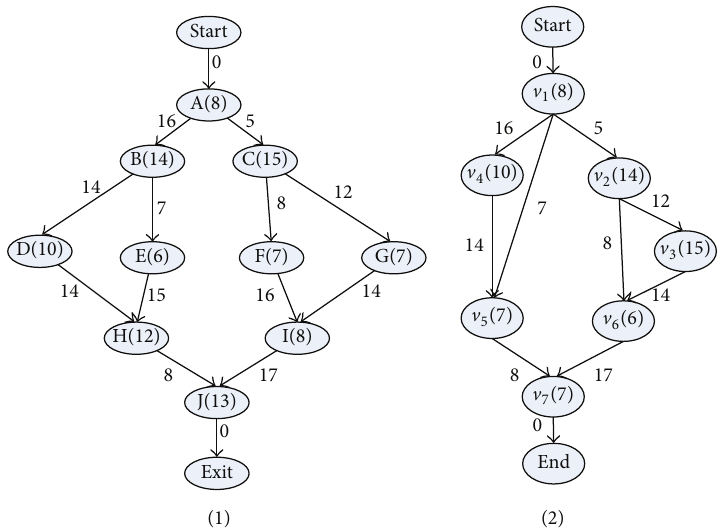
Figure 1: Two simple DAG models with 7 and 10 tasks.